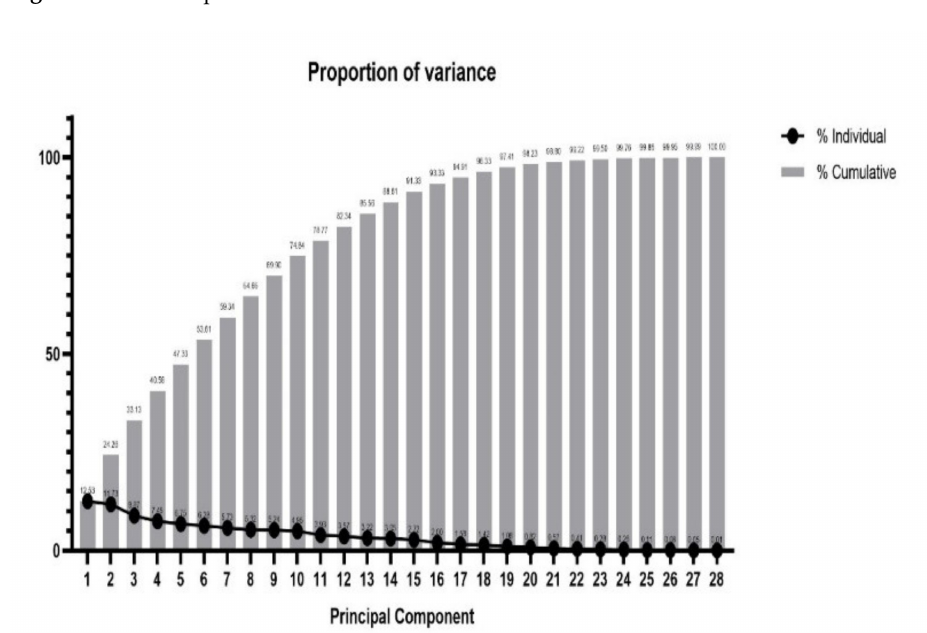
Figure 8. The scree plot for PCA.